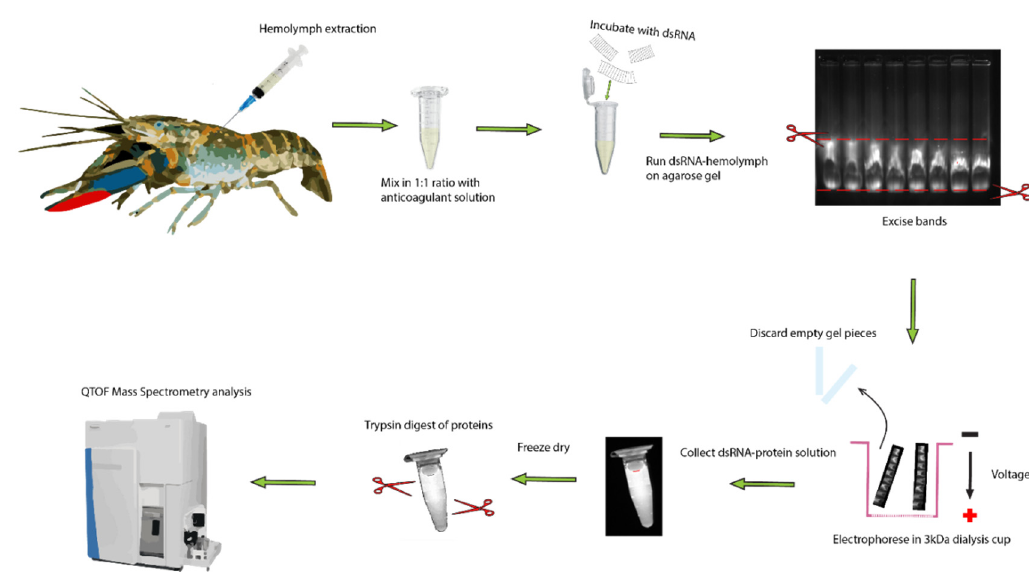
Figure 8. Extraction and identified of dsRNA binding proteins in serum of crayfish. The hemolymph was drawn from the ventral abdominal sinus of a crayfish and mixed with 1:1 volume of freshwater anticoagulant on ice. The hemolymph was spun down at 5000 × g for 5 min to remove hemocytes and cell debris. Then, 200 µL of serum was incubated with 20 µg of dsRNA and run on 0.8% agarose for 50 min at 100 V. The band was then excised under UV light and placed in a 3 kDa dialysis cup, which was placed back in the gel running tank and electrophoresed for another 50 min at 100 V. The resultant solution containing dsRNA bound to protein was collected and lyophilized. Following this, the proteins were trypsinized and analyzed via mass spectrometry.